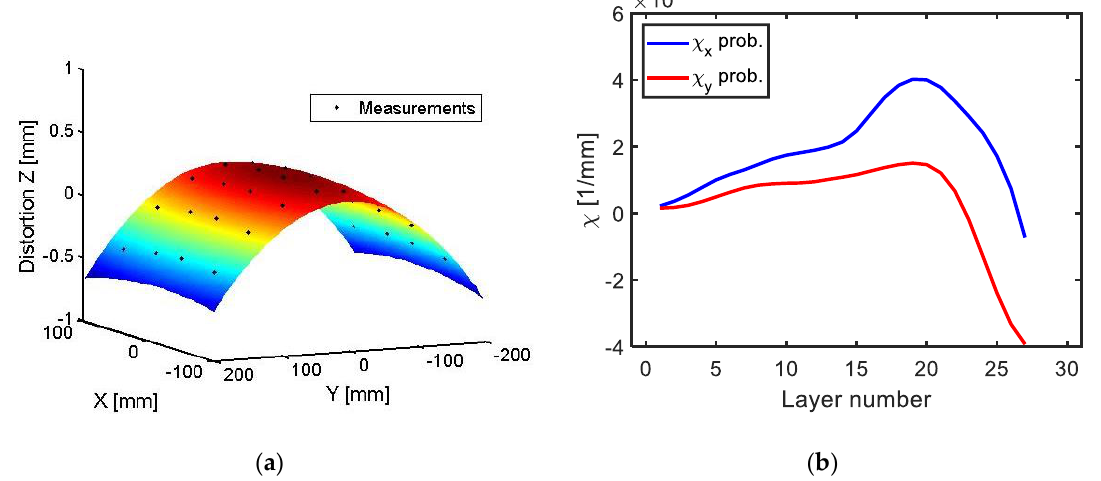
Figure 8. Curvature obtained from distortion measurements by quadratic regression in X and Y directions for a specific layer ( a ), and curvature evolution for all layers measured by probing in the LR test ( b ).